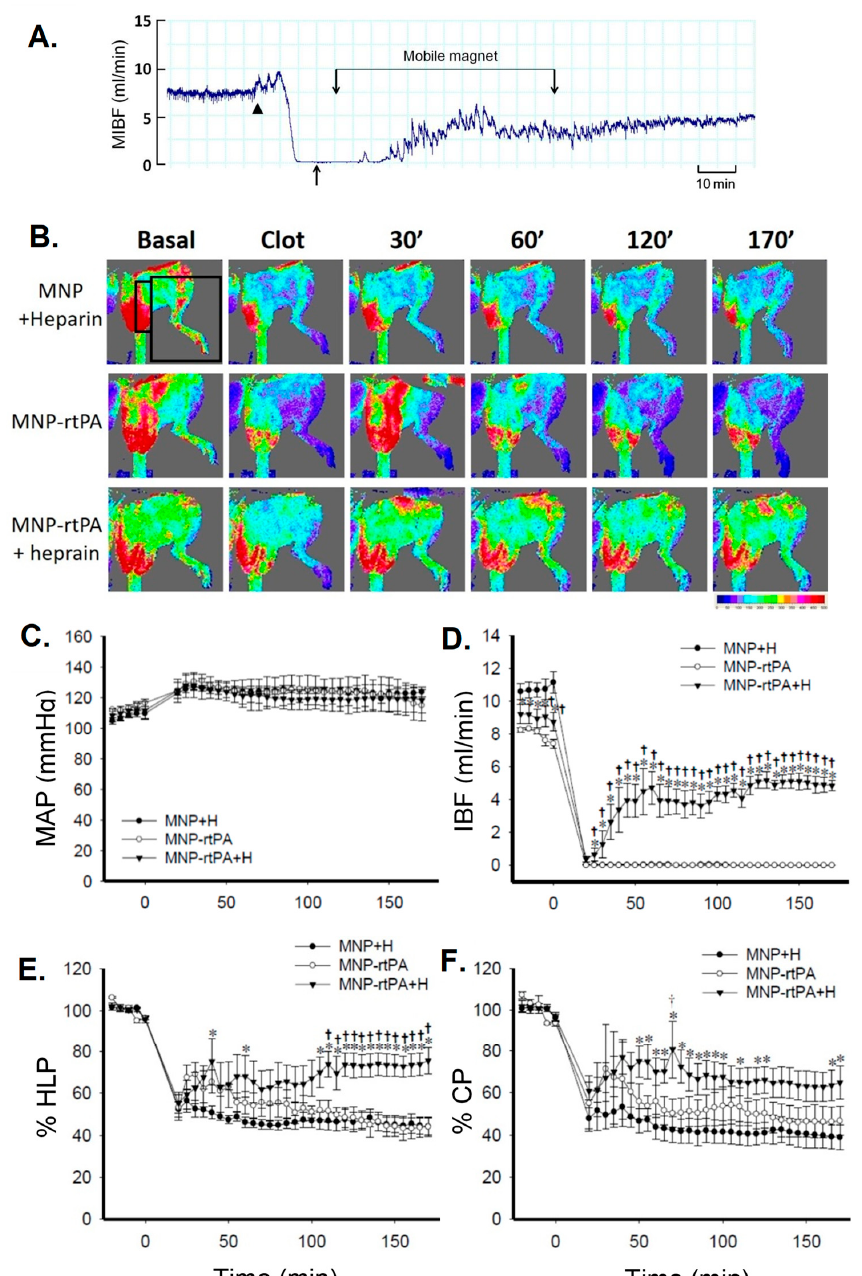
Figure 4. Target thrombolysis induced by immobilized rtPA plus heparin under magnetic guiding in a FeCl 3 thrombosis model of the rat. ( A ) illustrates representative effects of MNP-rtPA plus heparin on the mean iliac artery blood flow (MIBF). FeCl 3 -induced thrombosis (arrow head) reduced left iliac blood flow to below 1 mL / min; MNP-rtPA (0.2 mg / kg) with heparin (500 mg / kg plus 500 IU / kg . hr for one hr) was administered from the right iliac artery, as indicated by the arrow. ( B ) Tissue perfusion of hind limb (HLP) and cremaster muscle (CP) was measured by laser speckle contrast imaging; the signals acquired in the areas are denoted as in the squares. Mean arterial pressure (MAP; C ), mean iliac blood flow (MIBF; D ), HLP ( E ) and CP ( F ) were measured with time. FeCl 3 (20%) filter paper was placed on the left iliac artery at time 0. MNP-rtPA with heparin (H; 500 mg / kg plus 500 IU / kg . h for one hour; n = 5) or equivalent MNP with heparin was administered from the right iliac artery 5 min after complete occlusion. Values were presented as mean ± SE. *, p < 0.05 compared with the corresponding control group. † , p < 0.05 compared with the corresponding MNP-rtPA